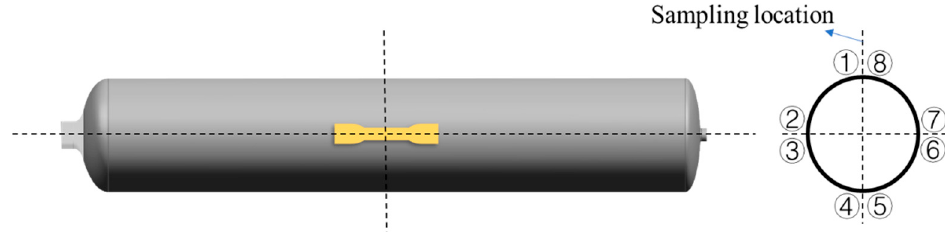
Figure 16. Preparation process of test strips for mechanical properties of PA11 liner